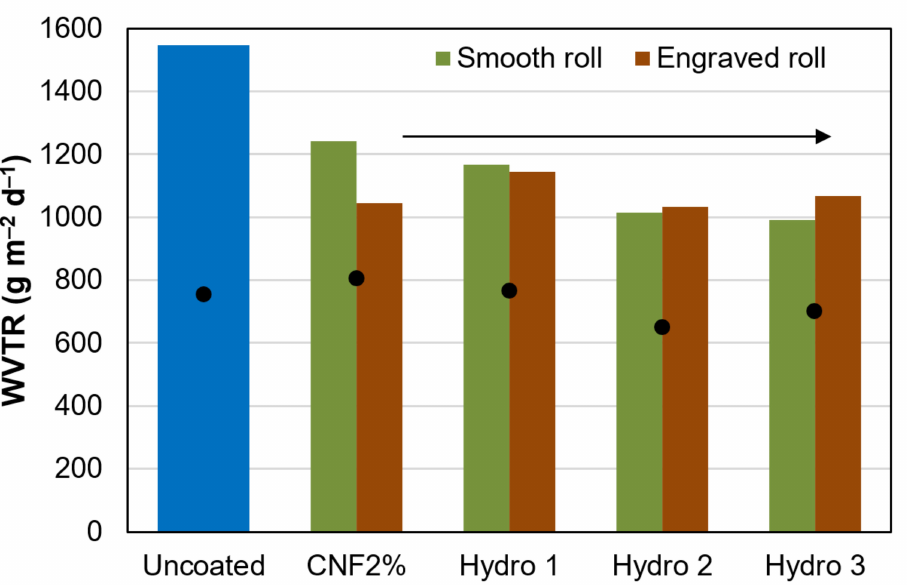
Figure 3. Maximum (columns) and 24-h average (dots) water vapor transmission rate through uncoated paper and through sheets that were coated with formulations Hydro 1–3